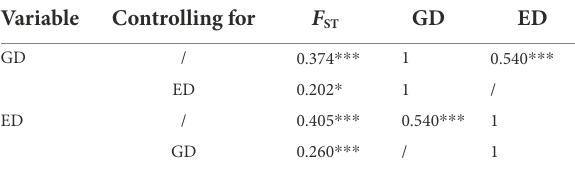
TABLE 3 Mantel and partial mantel tests for the correlation between genetic, geographic, and environmental distances. Variable Controlling for F ST